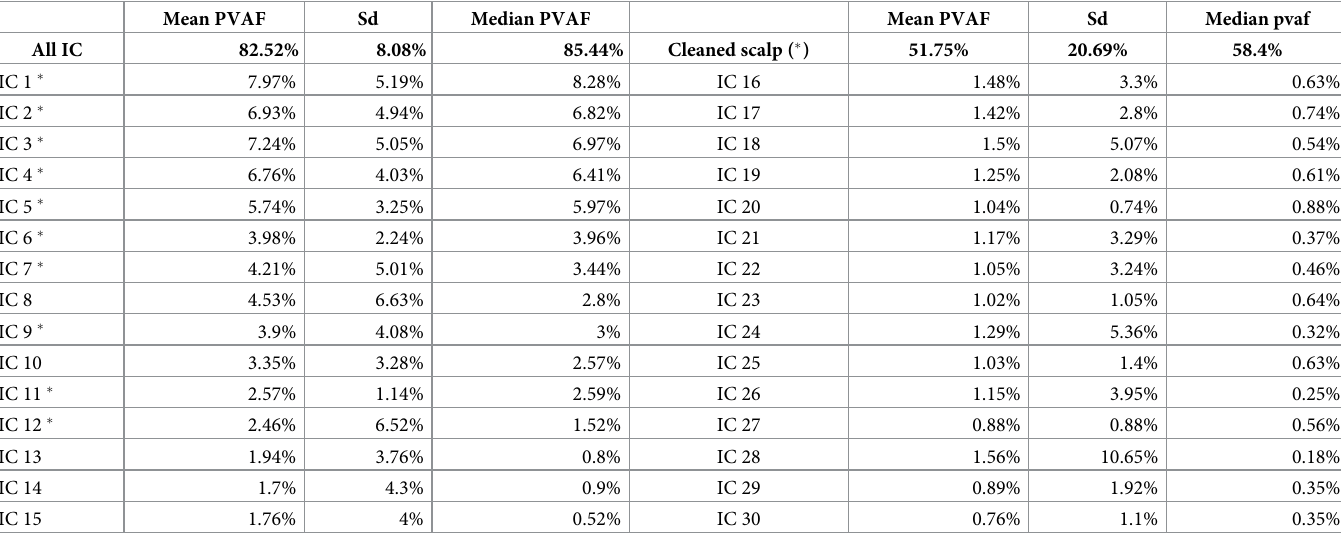
IC 15 1.76% 4% 0.52% IC 30 0.76% 1.1% 0.35% PVAF (percentage of variance accounted for) values for each